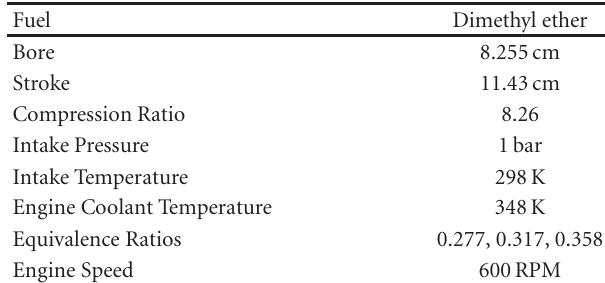
Table 3: Operating conditions for the pressure trace simulation of the CFR engine.